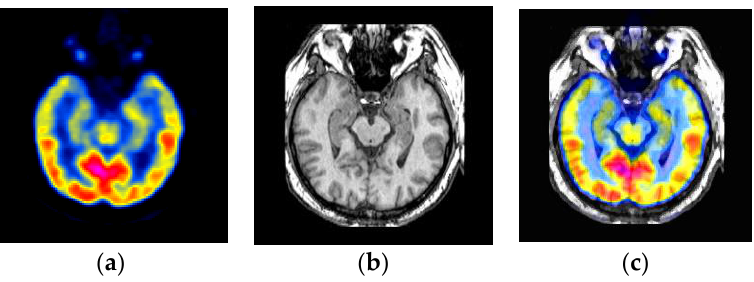
Figure 6. Examples of medical image fusion. From left to right: ( a ) PET image, ( b ) MRI image, ( c ) fused image. Electronics 2020 , 9 , x FOR PEER REVIEW